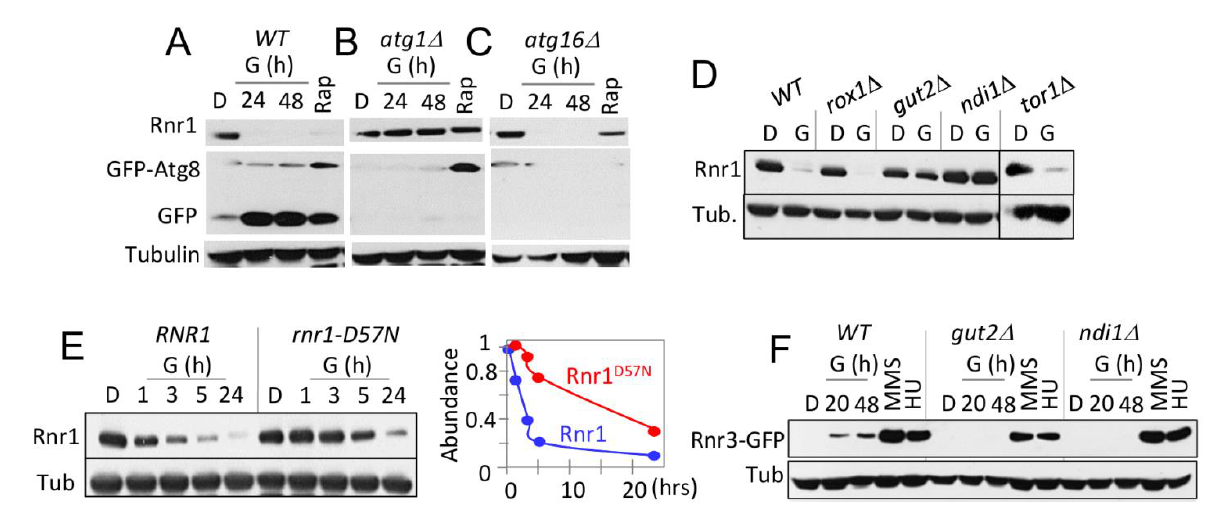
FIGURE 4: Carbon source dependent down regulation of Rnr1 is dependent on oxidative phosphorylation and the conserved ATP/dATP binding site. (A) WT cells transformed with a GFP-ATG8 plasmid was grown to mid log phase in leucine drop out medium